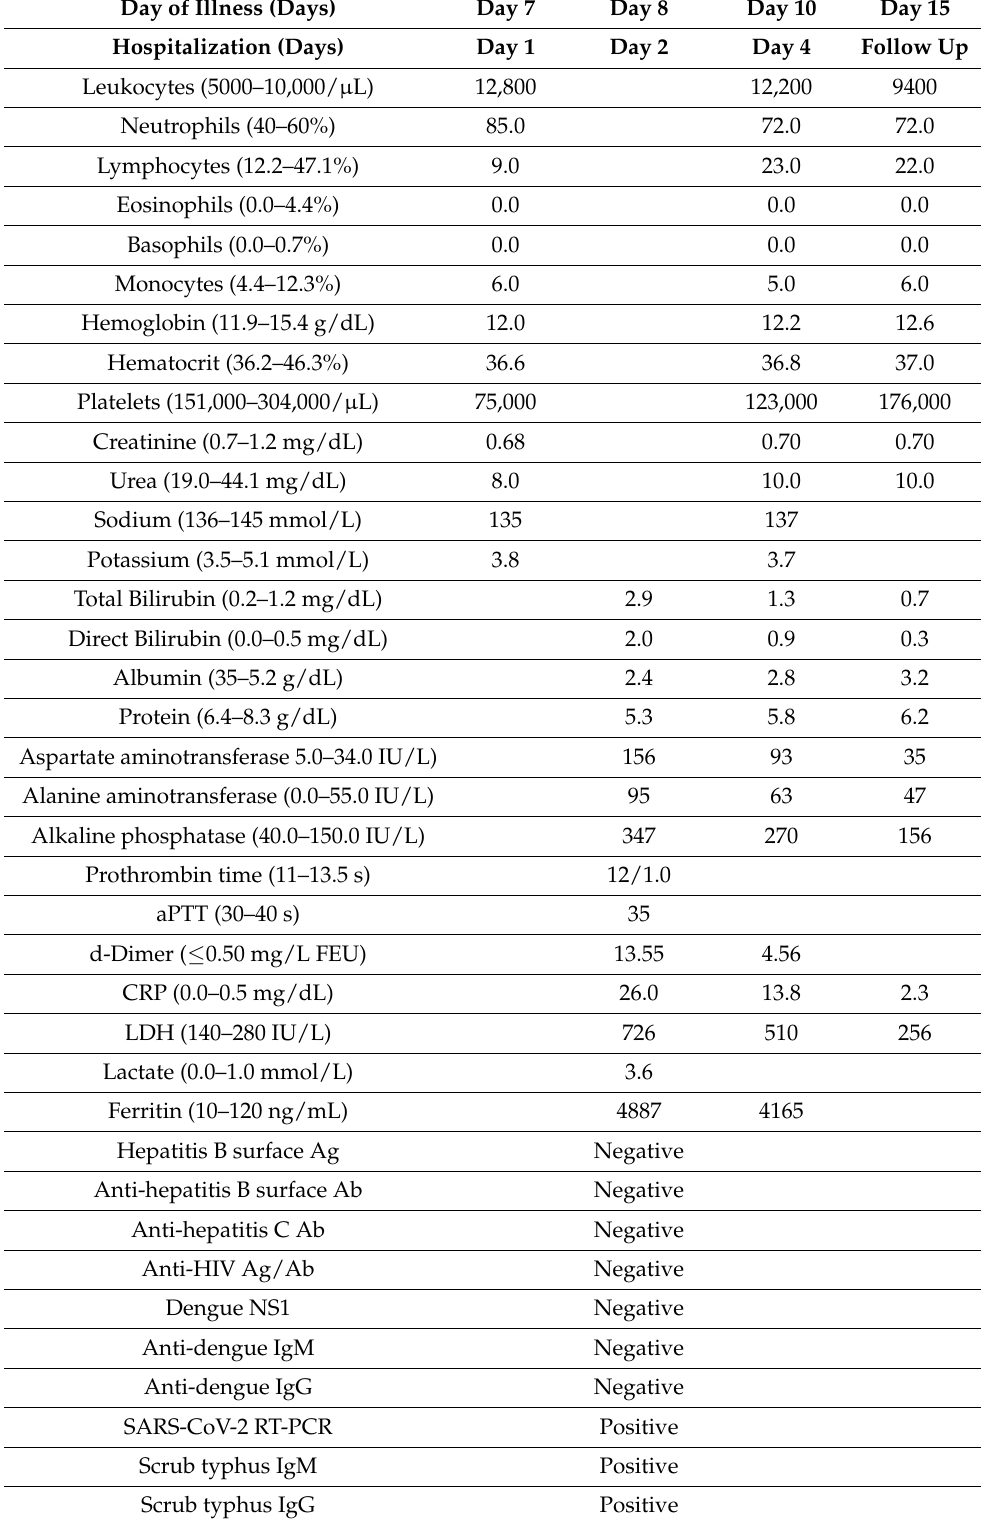
Table 1. Serial laboratory parameters from the time of presentation to the end of follow